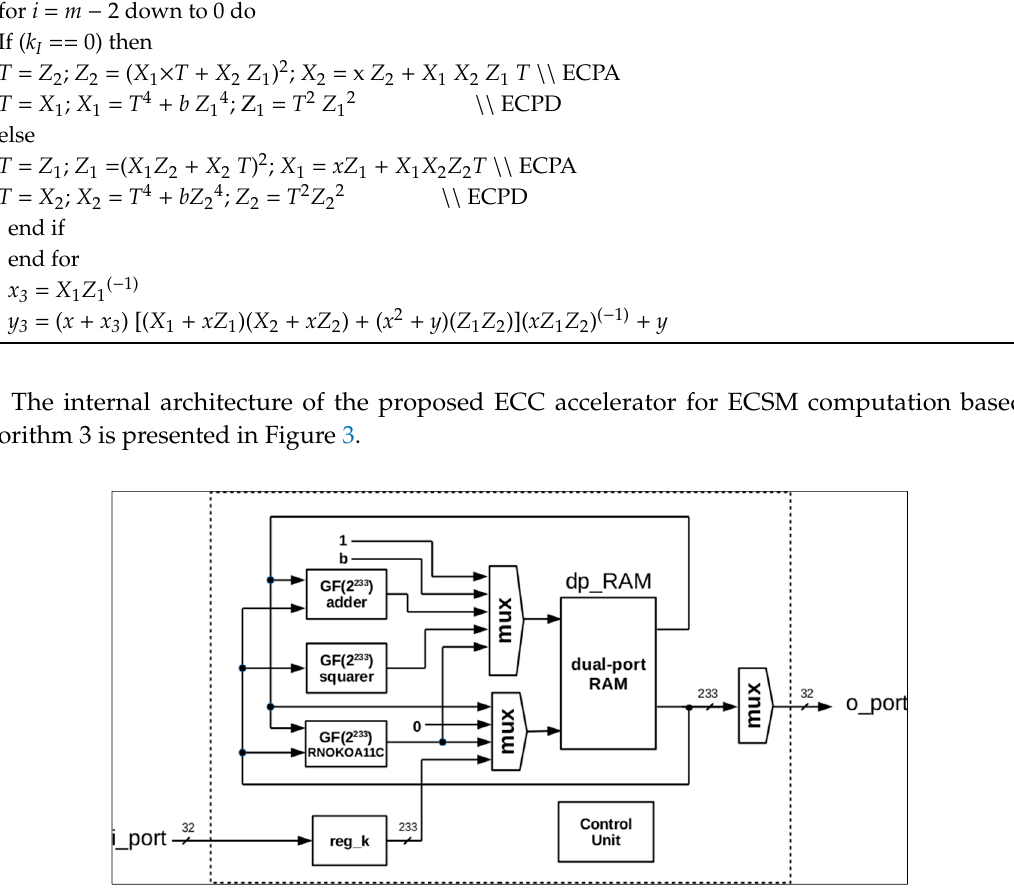
Figure 3. Hardware architecture of ECC (Elliptic Curve Cryptosystems) accelerator.